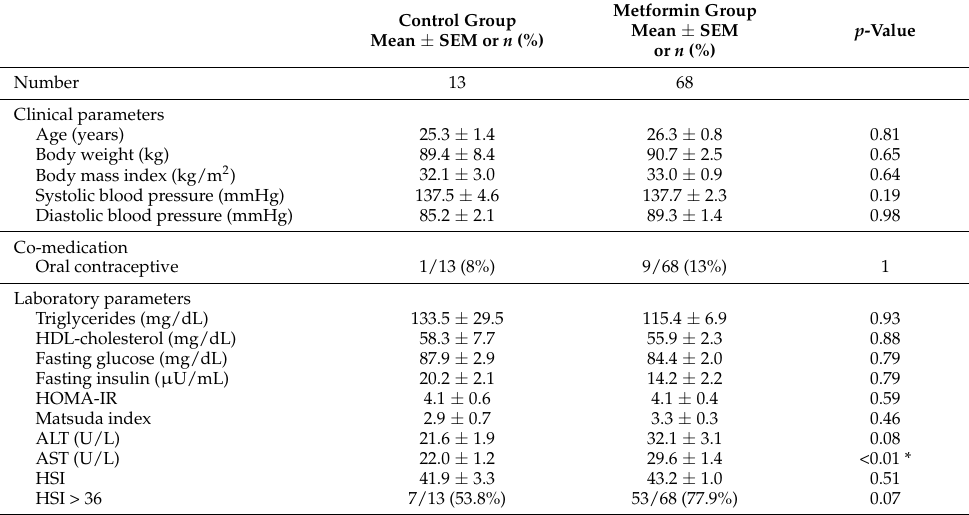
Table 1. Baseline characteristics of the control and metformin